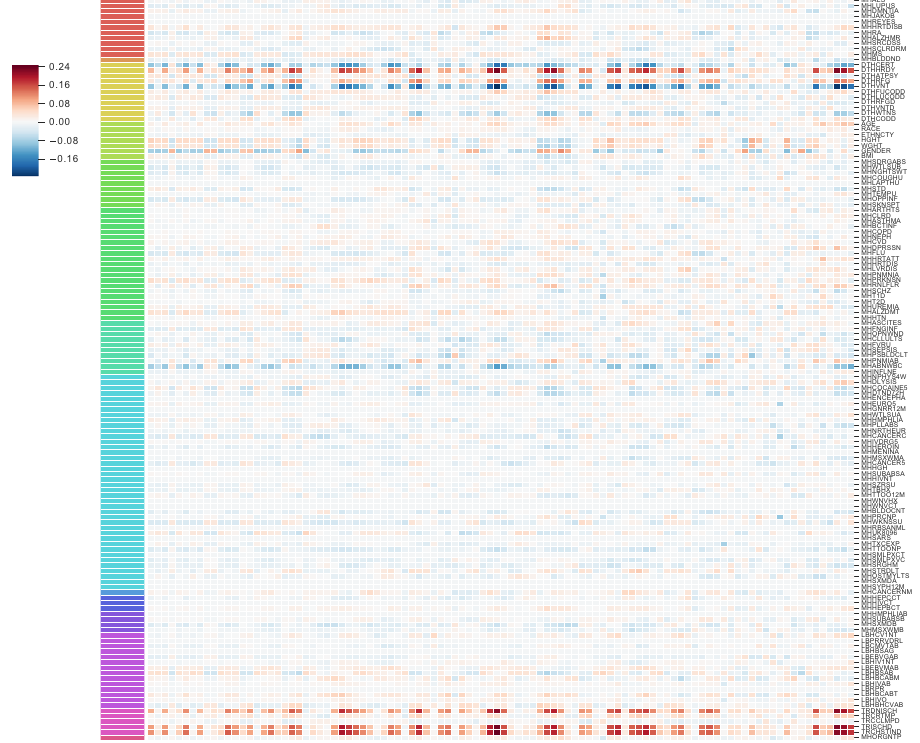
Fig. 4 Pearson ’ s correlation of 100 components of GTEx CCA with GTEx covariates. The 100 GTEx CCA components are ordered on the x -axis; 138 available GTEx covariates are on the y -axis. The legend on the left refers to the Pearson ’ s correlation between each component and the GTEx covariates. Some of the CCA components were sign- fl ipped so that the Pearson ’ s correlation with covariate Chest Incision Time was non-negative without loss of generality. The colors correspond to covariates in one of the following categories: Autoimmune, Degenerative, Neurological (red), Blood Donation (orange), Death Circumstances (yellow), Demography (yellow green), Evidence of HIV (light green), General Medical History (green), History at Time of Death (sea green), Information (light blue), Medical History (blue), Potential Exposure: Physical Contact (royal blue), Potential Exposure: Sexual Activity (purple), Serology Results (fuchsia), Tissue Recovery (pink), and Tissue Transplant (pink